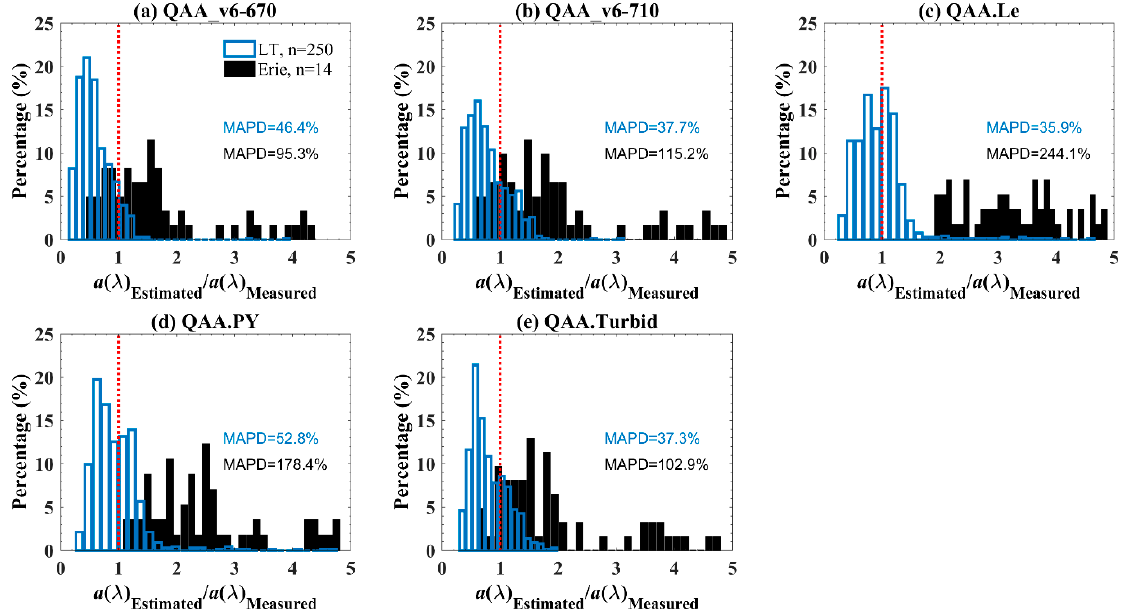
Figure 2. Evaluation of current IOPs approach for turbid waters for estimating a ( λ ) (seven wavebands were included in this figure, where λ = 413, 443, 490, 510, 560, 620, and 665 nm) with LT and Erie datasets, respectively.